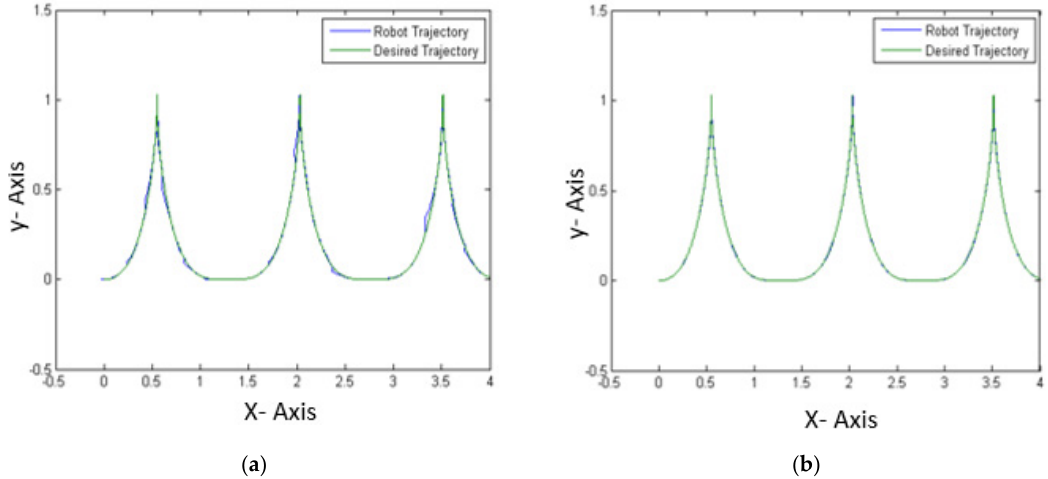
Figure 12. Best simulation OFHS ( a ) without noise and ( b ) with noise.